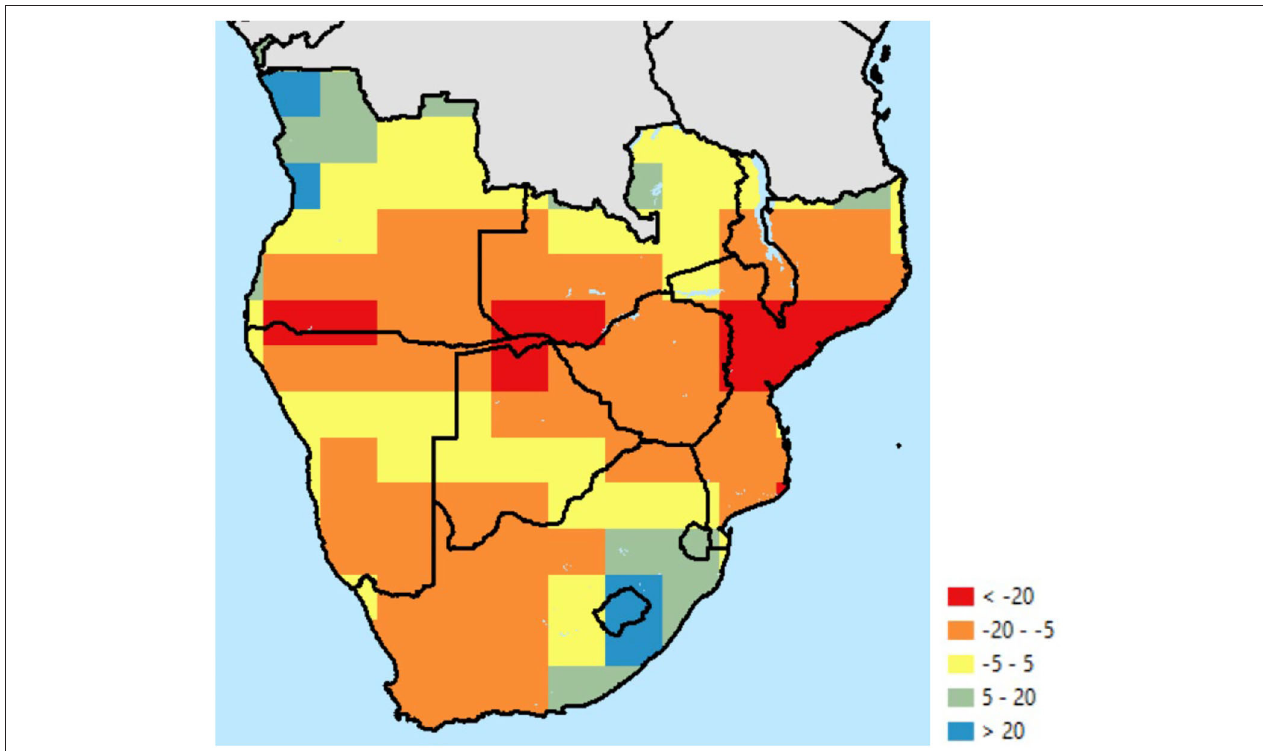
FIGURE 1 | Median projected change in annual precipitation across the ensemble of 7,200 smoothed climate change projections from 2020 to 2050 under the PF scenario, millimeters. Source: Authors calculations, based on Schlosser et al. (2021).